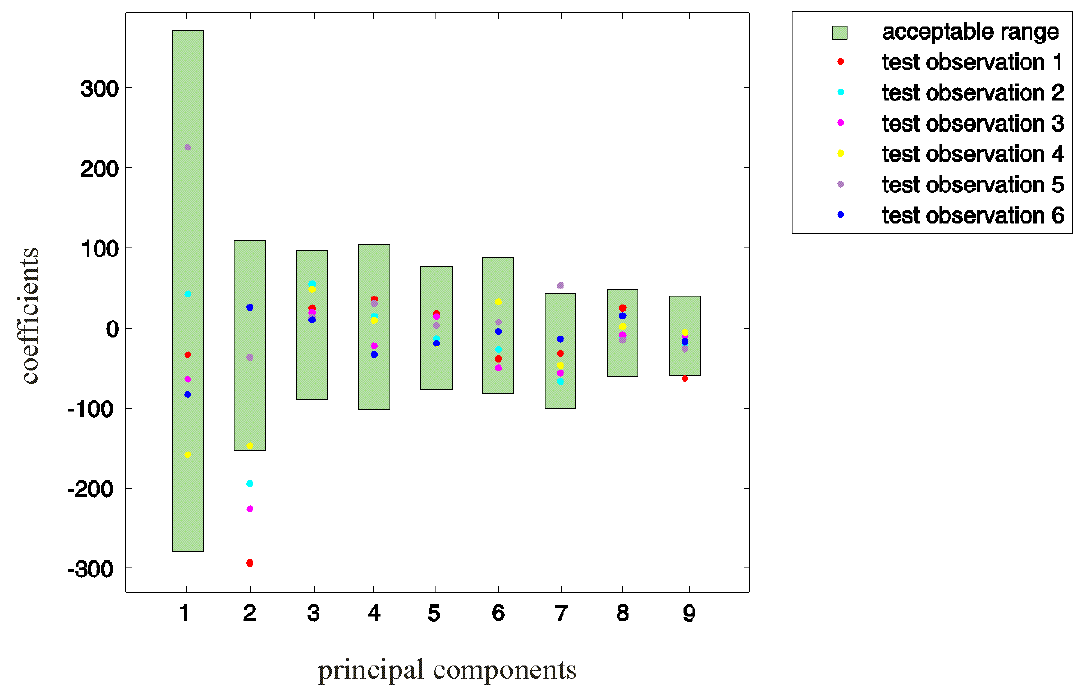
Figure 7. PCA coefficients of the test deviations from the desired swing motion. For test observations 1, 2, 3, and 5, at least one coefficient exceeds the acceptable range, indicating improper motion in the associated